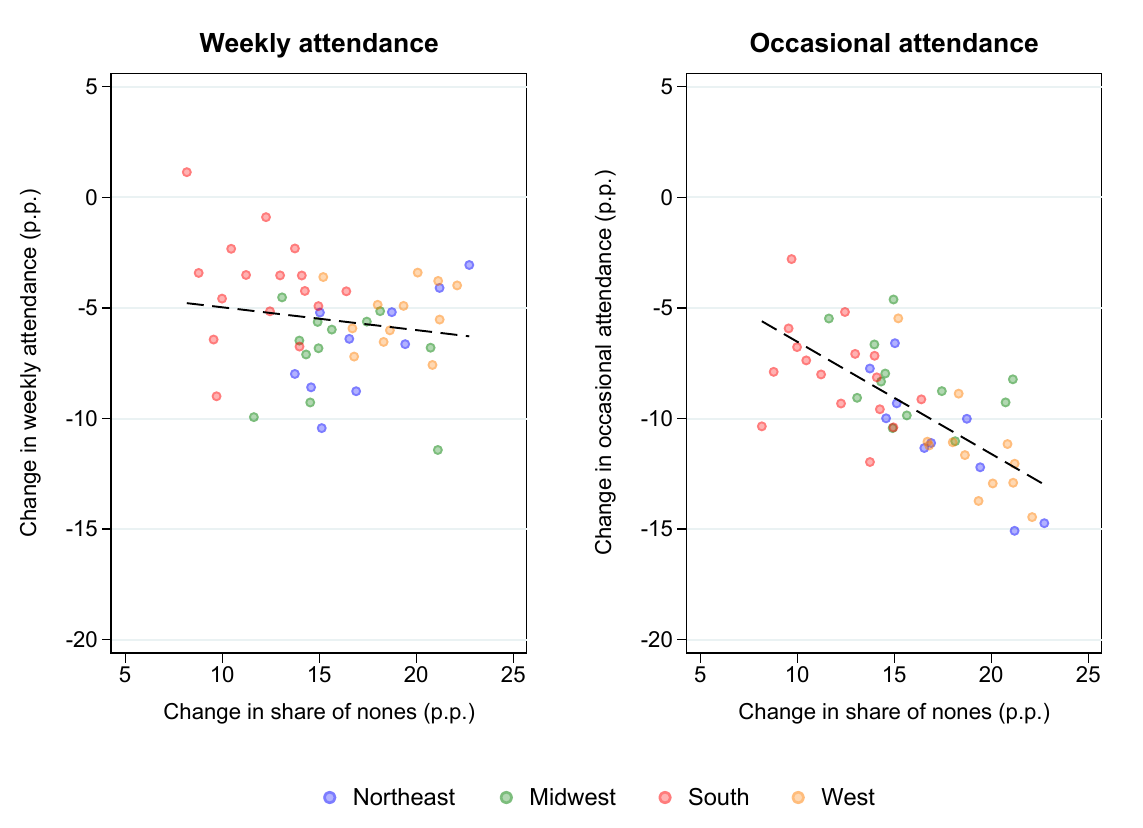
Figure 4: State-level trends in the share of religious nones and frequency of religious service attendance, 1990 to 2018. Notes: All axes are measured in percentage points (p.p.). The dashed lines depict the best- fitting lines. The correlation coefficient for the left panel equals − 0.16; the correlation coefficient for the right panel equals − 0.70. Utah, as an outlier, has been omitted from both graphs; its coordinates are ( 22, − 17 ) for the left panel and ( 22, 0 ) for the right panel. An interactive version of this figure is available